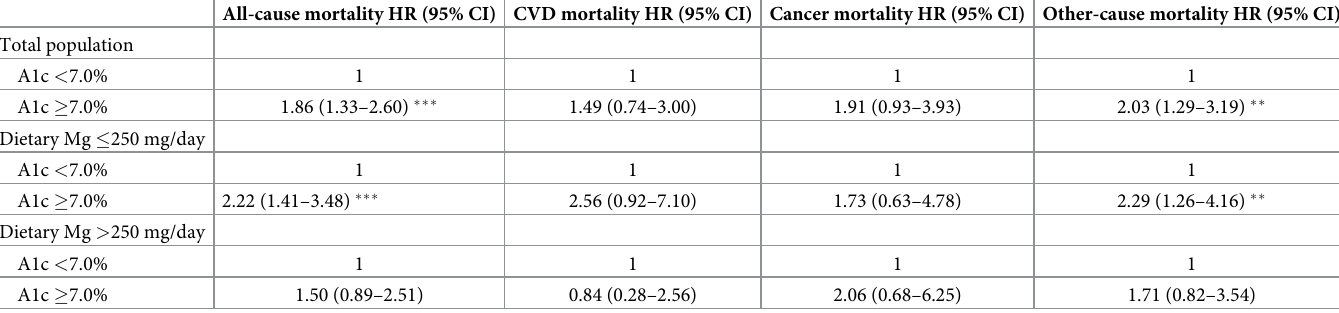
Table 3. All-cause and cause-specific mortality risk associated with HbA1c � 7.0% in the total population and in subgroups stratified by daily dietary magnesium (Mg) intake � and > 250 mg/day.